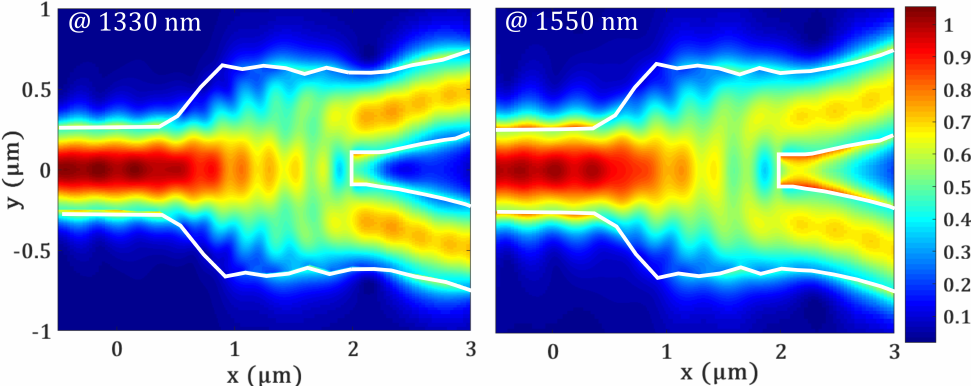
Figure 7. Normalized electric field distributions achieved with the best parameters after the the CMA-ES optimization at the O- and C-bands. Note that at 1330 nm ( left ), the evanescent field has a smaller magnitude than at 1550 nm ( right ) resulting in smaller loss at the gap between the two